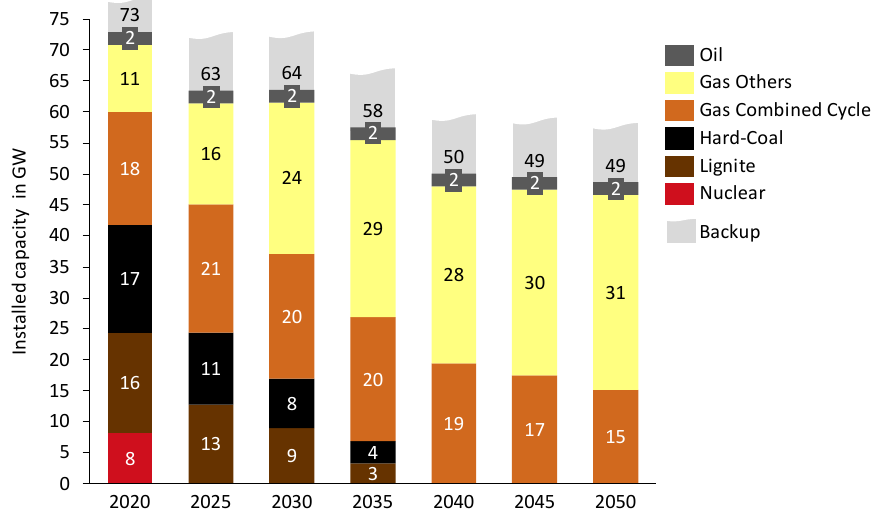
Figure 2. Installed conventional generation capacities Germany (excluding back-up capacities).